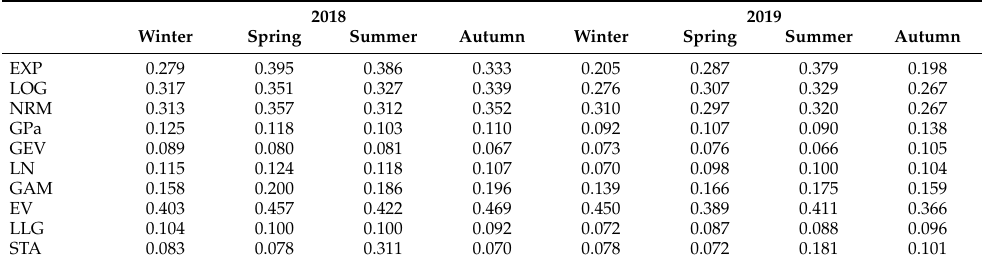
Table 11. KS-distances results for the Maximum likelihood, for the 300 m